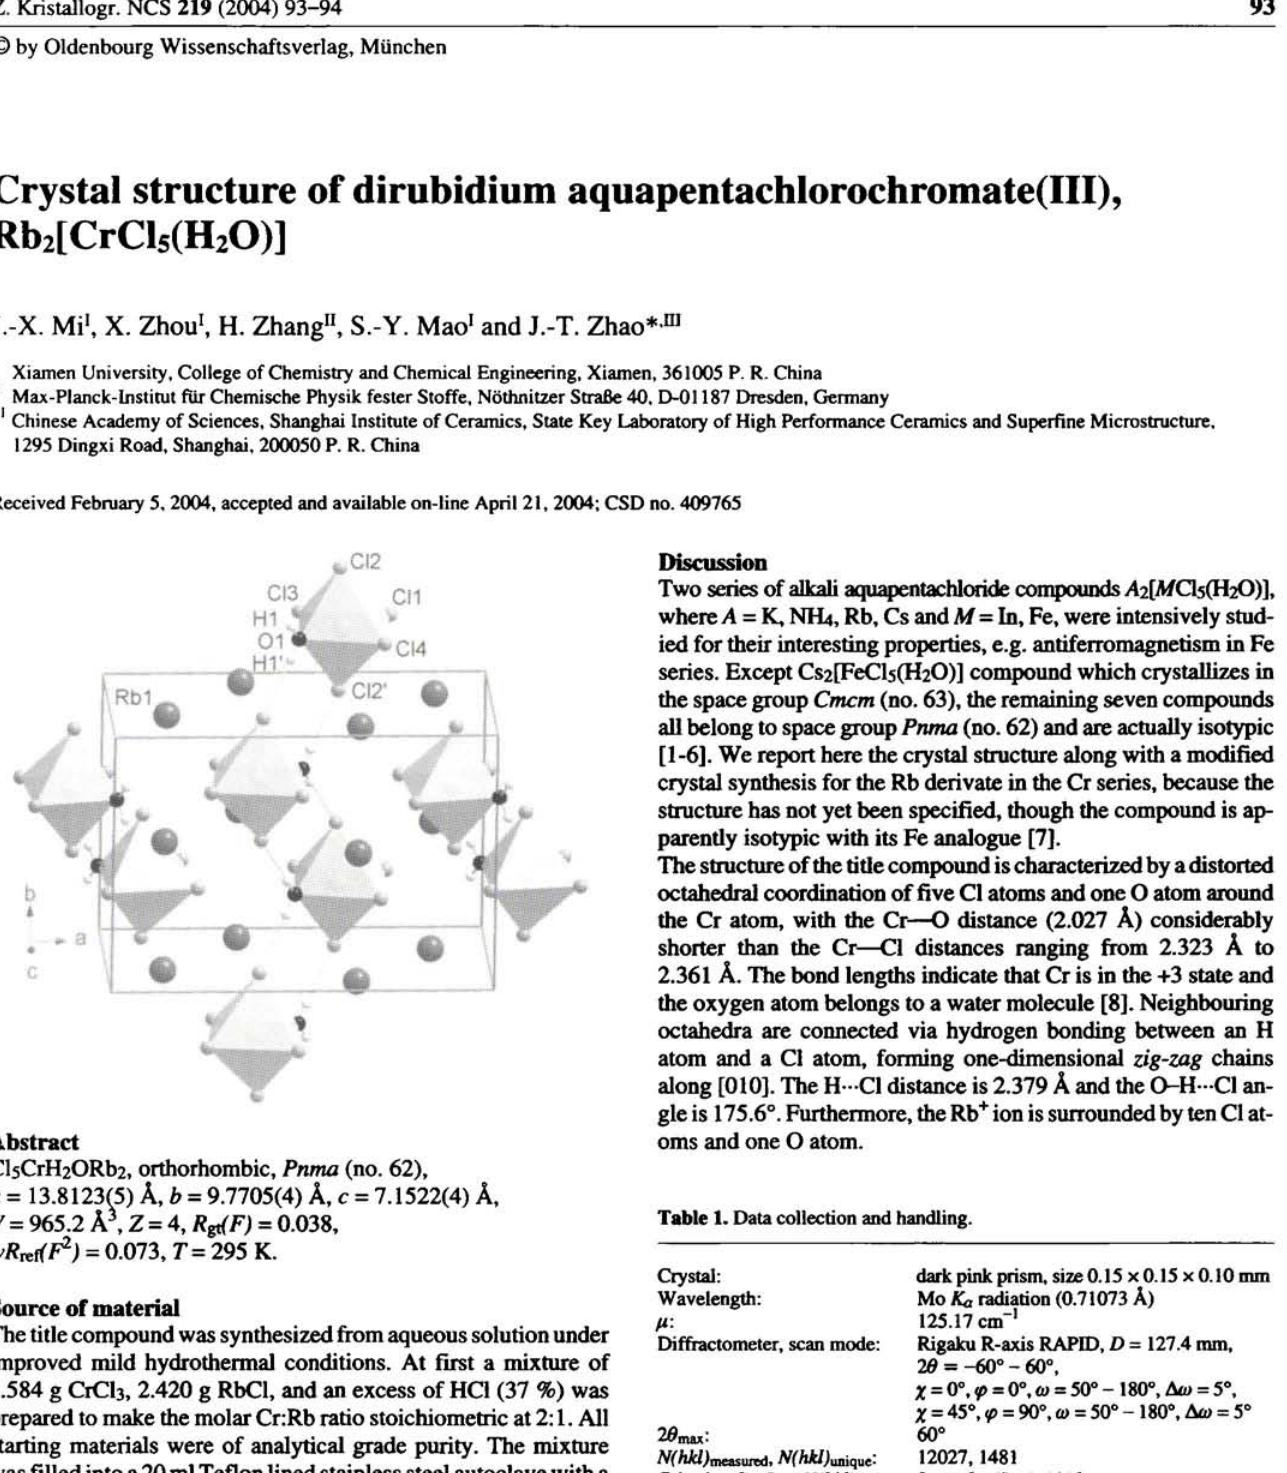
Table 1. Data collection and handling.